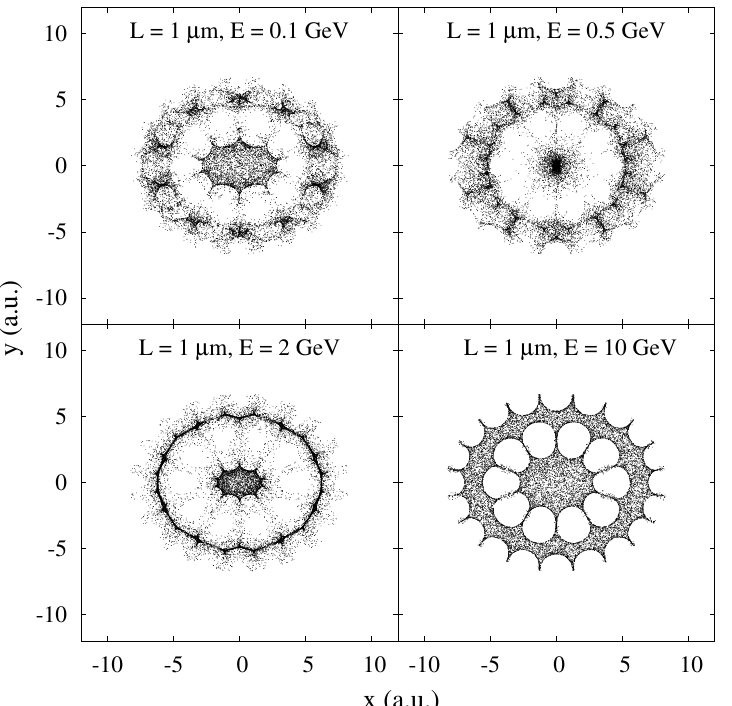
Figure 7. The spatial distributions of protons channeled in the radially deformed DWNTs(10, 0)@(5, 0) for different proton energies: (left top) E = 0.1 GeV; (right top) E = 0.5 GeV; (left down) E = 2 GeV; (right down) E = 10 GeV, respectively. The radial strain is η = 0.1 and nanotube length is L = 1 µ m.